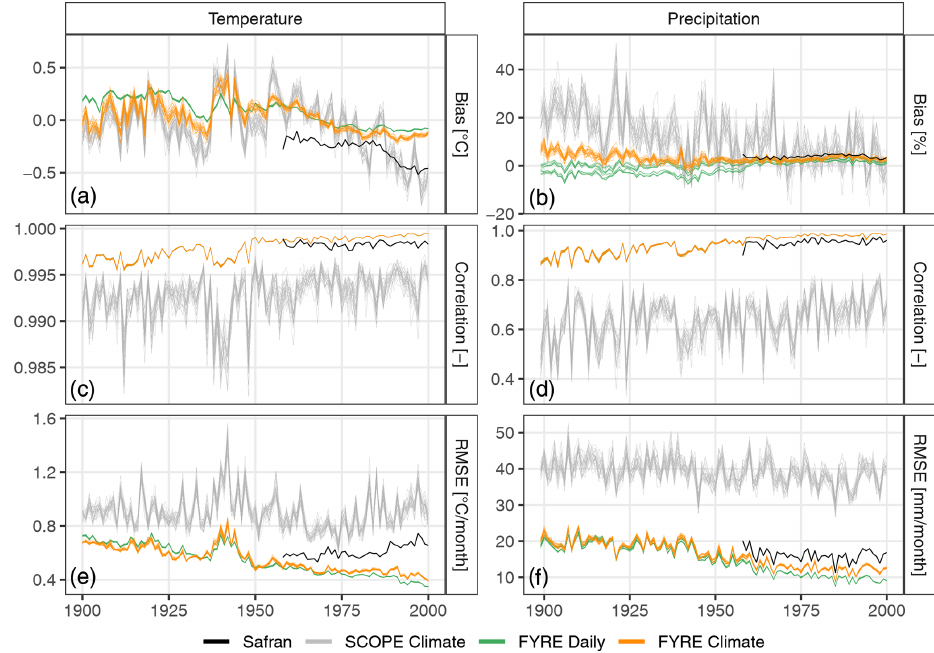
Figure 7. Similar to Fig. 6, but over the 1900–2000 period with corresponding centennial homogenized time series.